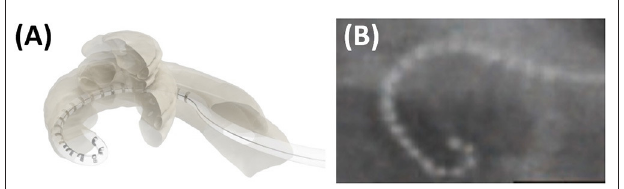
FIGURE 3 | Cartoon picture demonstrating how an electrode tip fold over would look like (A) . Post-operative plain film x-ray showing electrode tip